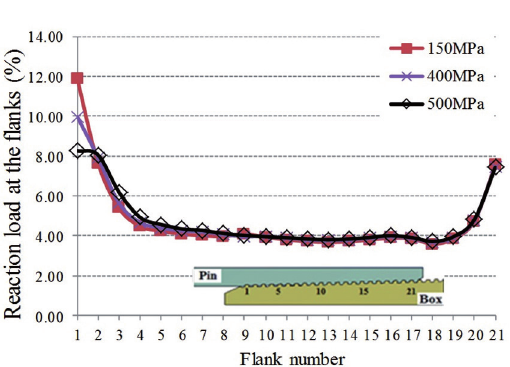
Figure 8: Results of load distribution over the flanks of API Buttress casing